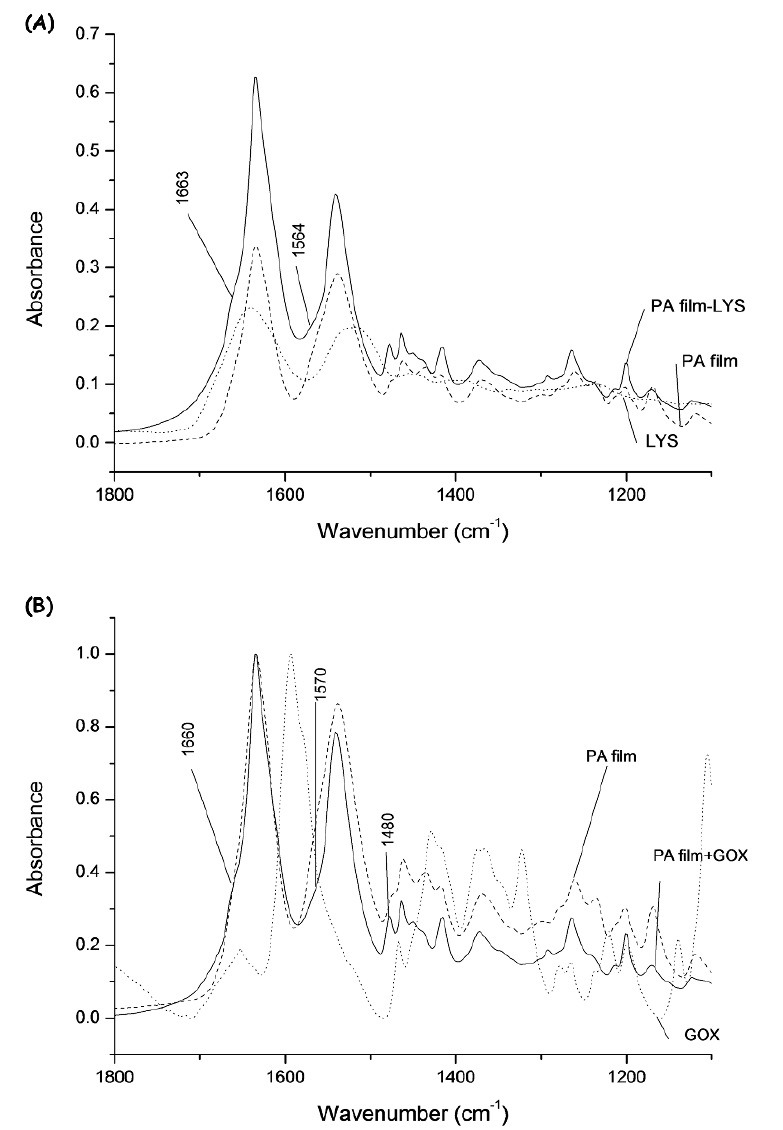
Figure 2. FTIR spectra of polyamide film with immobilized lysozyme (A) and glucose oxidase